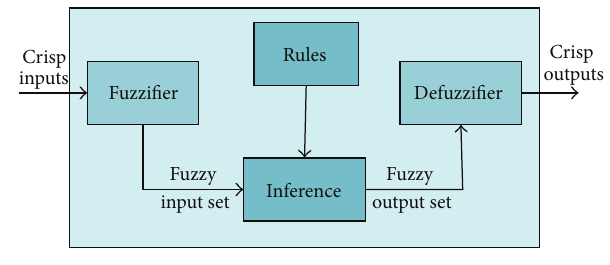
Figure 2: Fuzzy logic